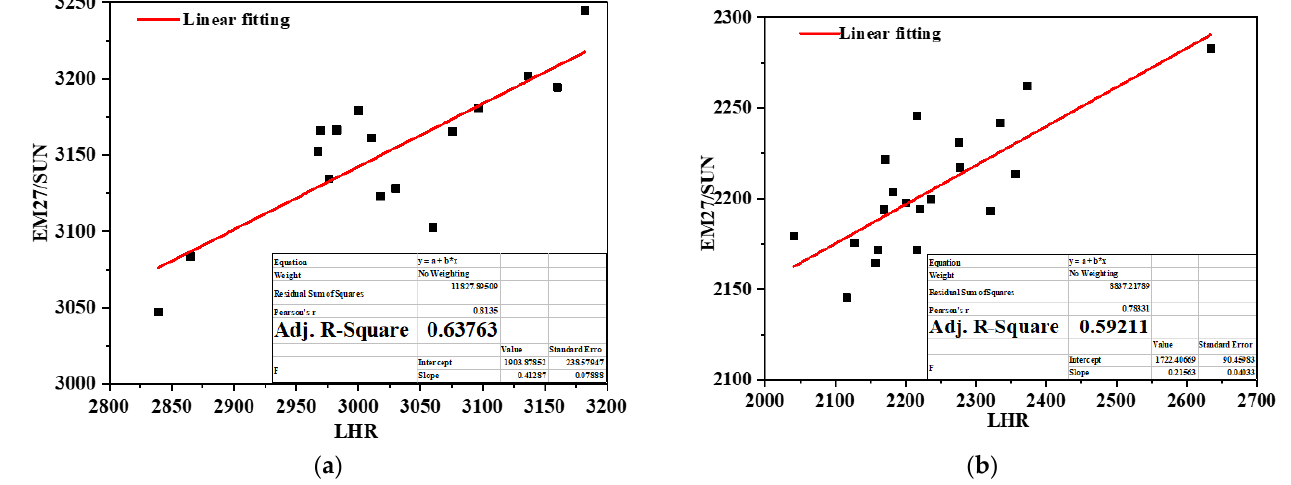
Figure 11. The correlation analysis of LHR and EM27/SUN water vapor measurements on ( a ) 20 and ( b ) 21 July. The average values of water vapor measured by LHR were 3023 ppmv on 20th and 2239 ppmv on 21st, the EM27/SUN’s results were 3152 ppmv and 2201 ppmv, respectively. The relative errors are 4.09% and 1.73%, and the correlations between LHR and EM27/SUN are around 0.6 (0.637 and 0.592). The column densities of methane retrieved by LHR and EM27/SUN are shown in Figure 12.